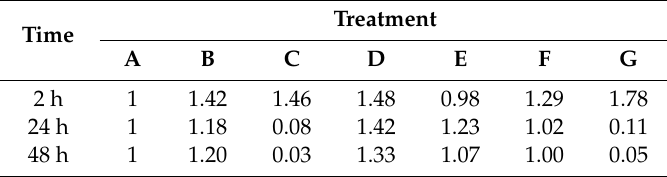
Table 3. Cardiac progenitor cells relative viability fold change depending on time and treatment, compared to the control group; (A) control culture; (B) culture with 2 µ g / mL AgNP; (C) culture with 10 µ g / mL AgNP; (D) culture with 0.4 µ g / mL HNC; (E) culture with 2 µ g / mL HNC; (F) culture